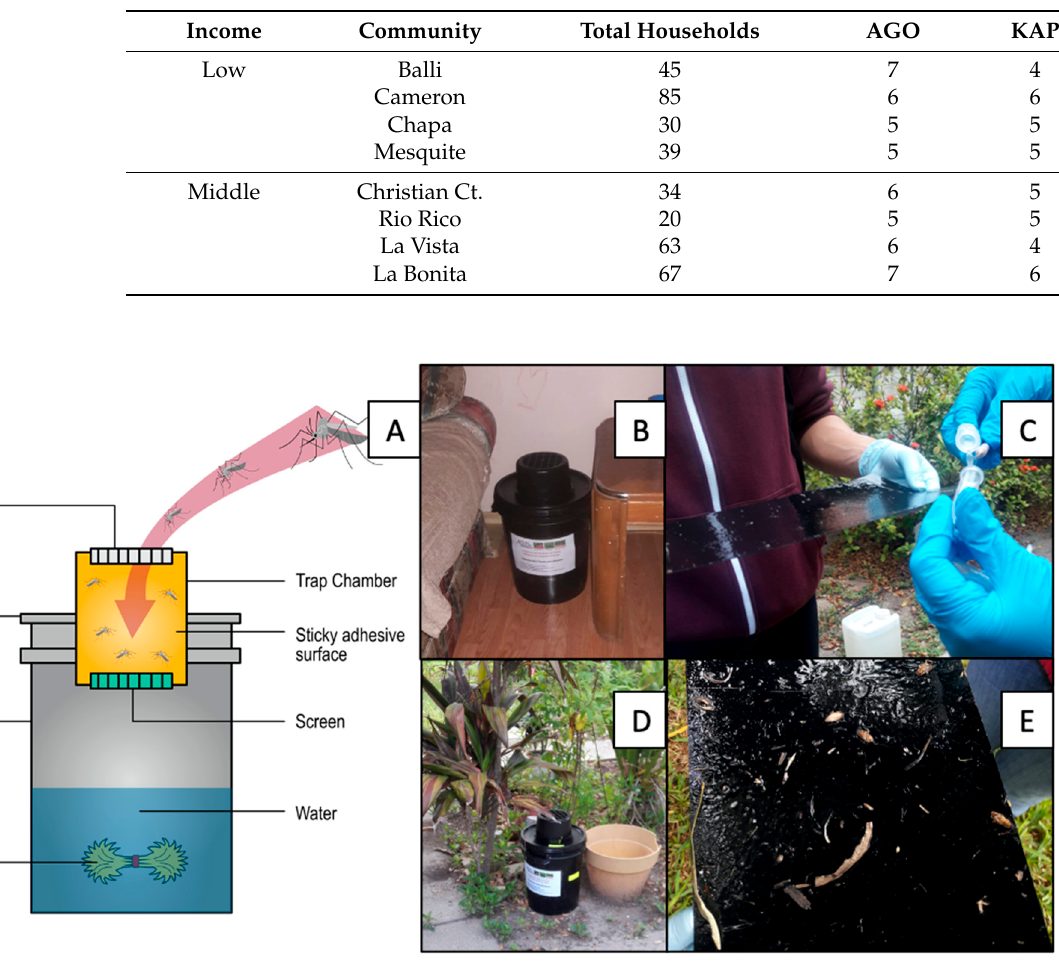
Figure 2. Pictorial diagram and field usage of the AGO trap (Source: CDC, Spring Star, King 5–modified). ( A ) Diagram of the features and components of the AGO trap. ( B ) Indoor placement of AGO. ( C ) Mosquito method of collection from glue board. ( D ) Outdoor placement of AGO. ( E ) Field view of a glue board that needs replacement.